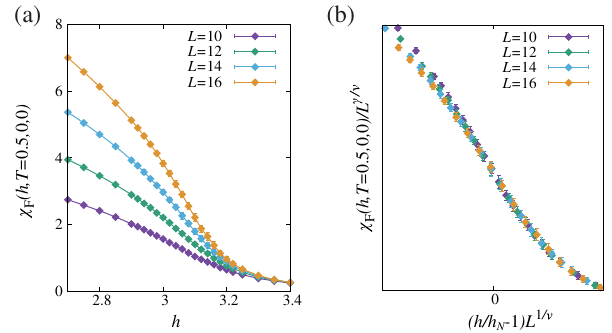
FIG. 9. Inverse Ising spin susceptibility [ χ ð h; T ¼ 0 . 1 ; 0 ; 0 Þ ] away from QCP ( h > h c ) as a function of j h − h c j . Here, the temperature is T ¼ 0 . 1 , and χ − 1 ð h c ; T ¼ 0 . 1 ; 0 ; 0 Þ has been deducted in the plot. The slope of the log-log plot reveals the power γ ¼ 1 . 18 ð 4 Þ , and the intercept gives rise to the prefactor c 0 . 7 ð 1 Þ h ¼